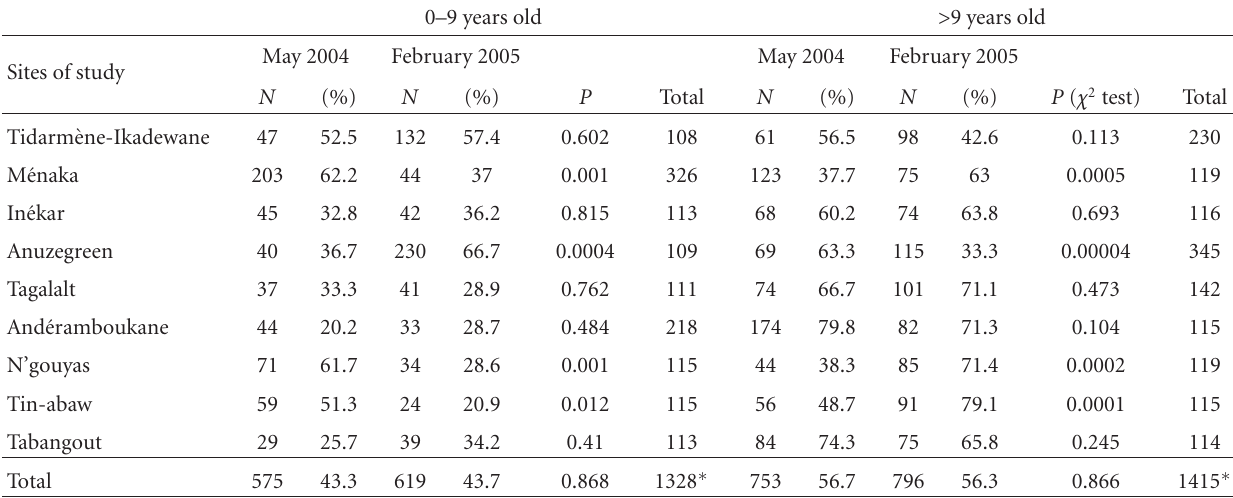
Table 1: Study population repartition by age group in May 2004 (Dry season) and in February 2005 (Cold season).